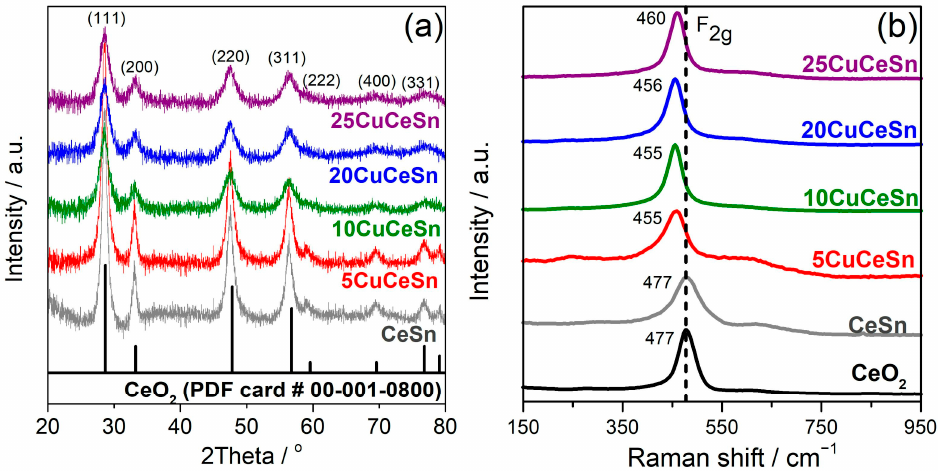
Figure 5. XRD patterns ( a ) and Raman spectra ( b ) of catalysts with different Cu contents. The sizes of Sn 4+ (0.81 Å for a coordination number of 8) and Cu 2+ (0.71 Å) cations are smaller than those of cerium cations (1.10 Å for Ce 3+ and 0.97 Å for Ce 4+ ). Therefore,